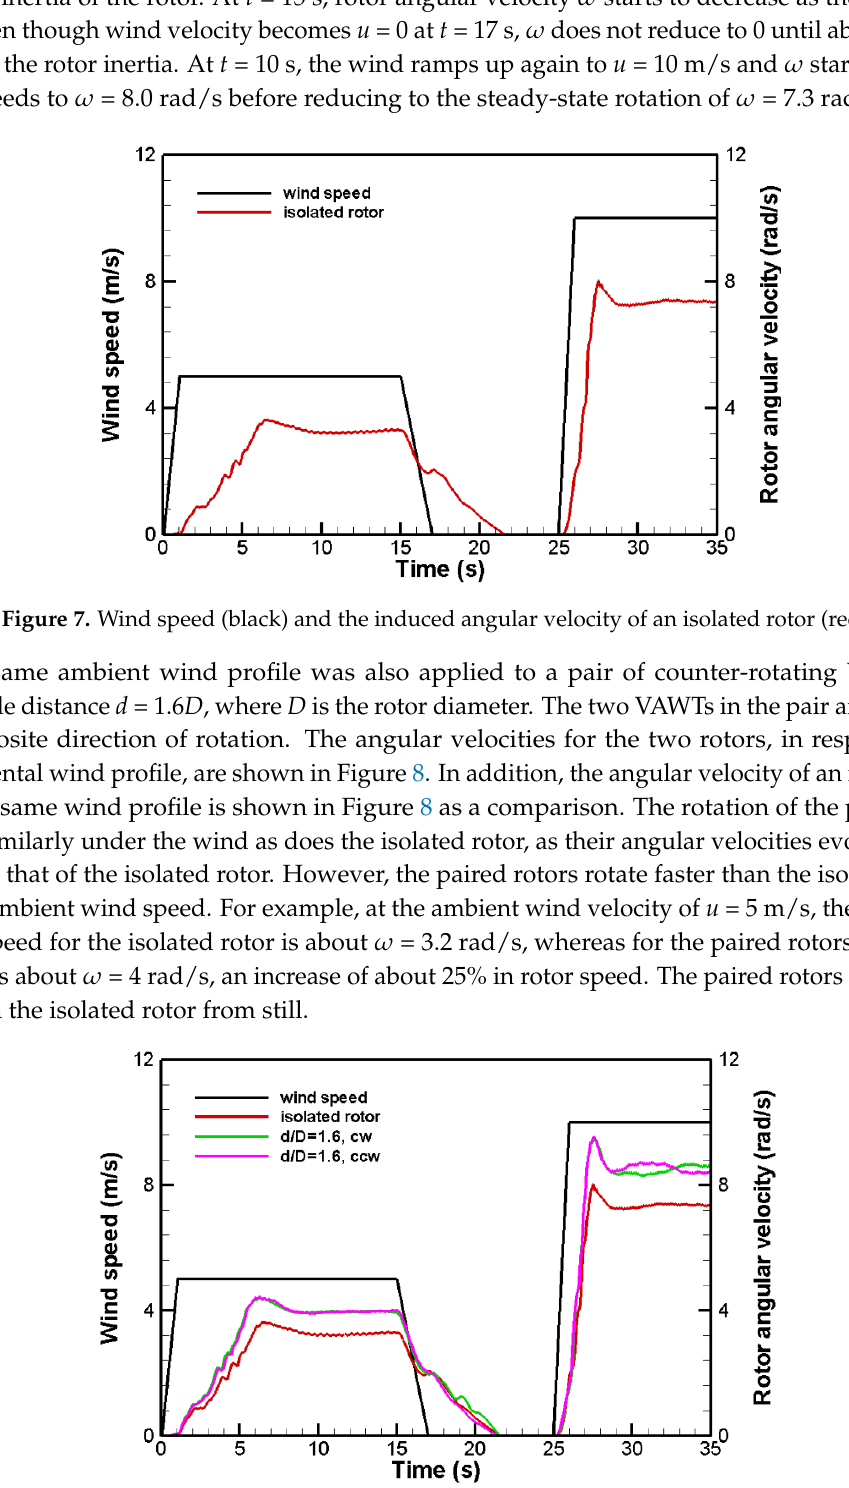
Figure 9. Both are steady-state rotations with ambient velocity u = 10 m/s. The vorticity near the blades